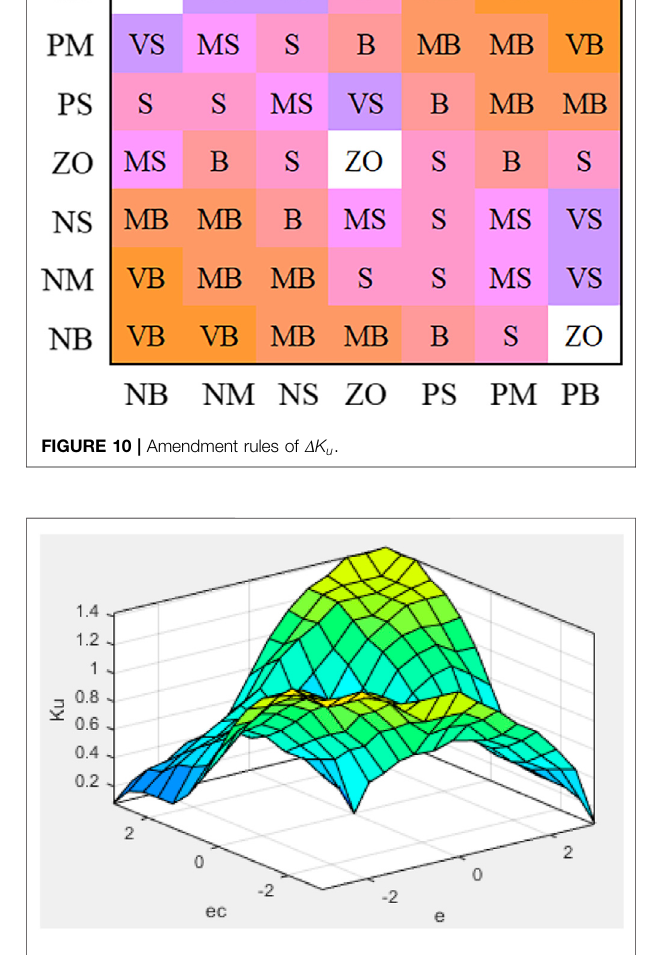
FIGURE 11 | Characteristic face of the Δ K u fuzzy inference system.